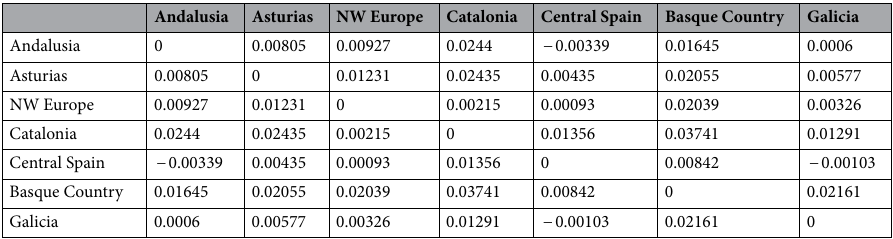
Table 4. Pairwise φ ST distance among geographical regions.